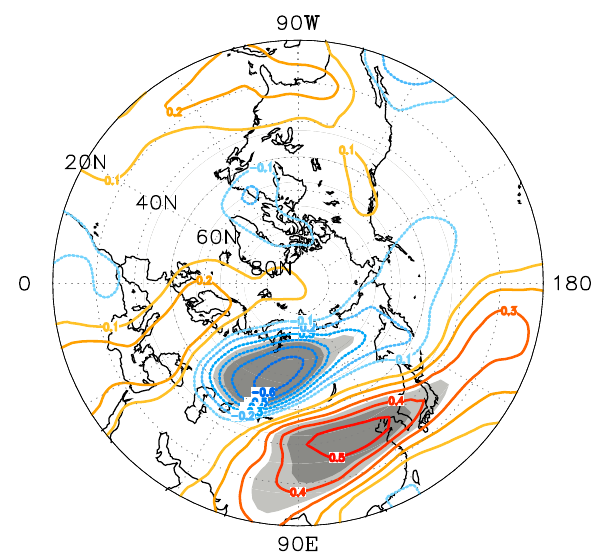
Figure 3. Correlation coefficient between the 500 hPa geopotential height and the number of haze-fog days in January from 1980 to 2015. The heavy shaded area denotes that the 99% confidence level is exceeded, and the light area indicates that it exceeds the 95% confidence level.